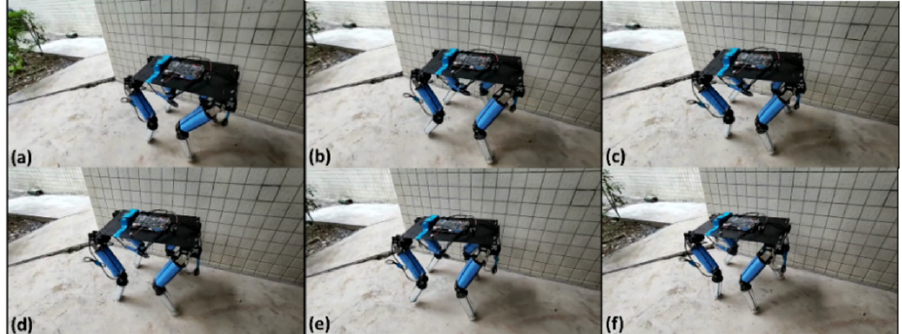
Figure 15. Experiment of real linear motion of robot. ( a – f ) represents the motion of the robot.